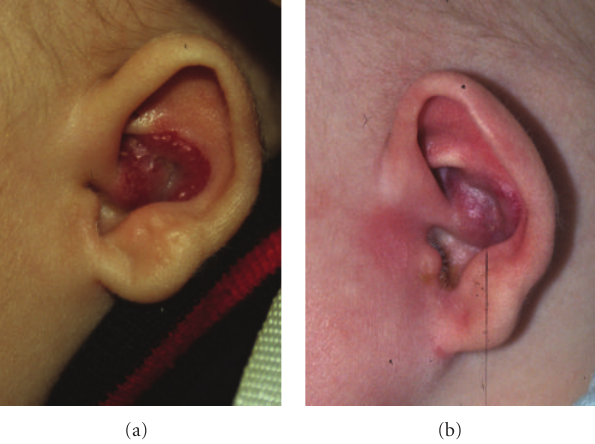
Figure 2: Infant 9 with haemangioma of the ear meatus, before and after 1 treatment with Photoderm.